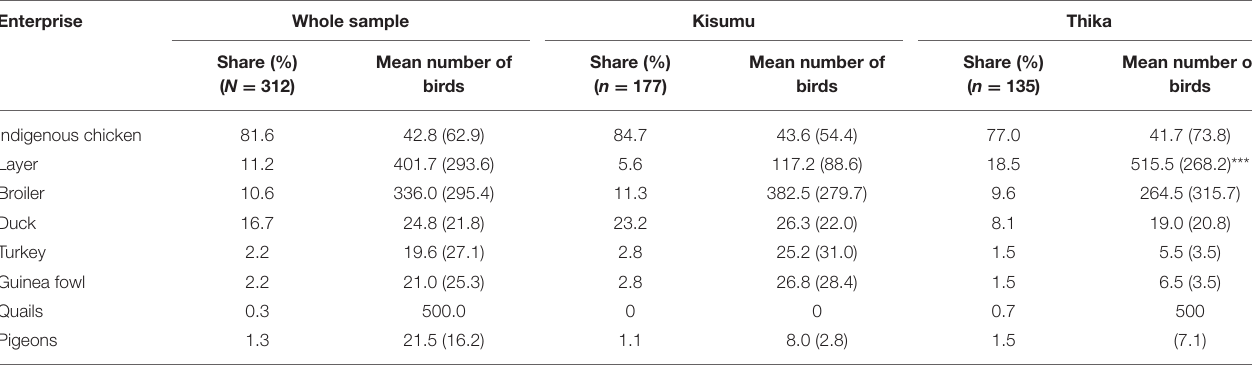
Figure in brackets is the standard deviation. ** Significant at 5%, *** significant at 1% (comparison of mean was tested using